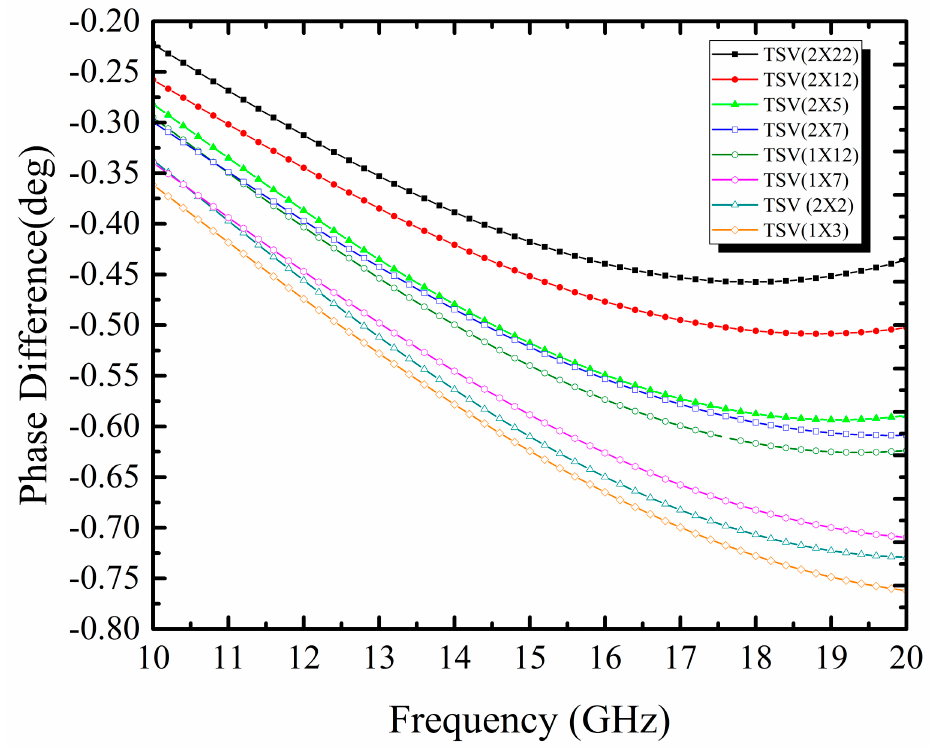
Figure 6. The simulation phase difference results with TSV size variation in proposed C p T-type topology in 4 dB attenuation cell.